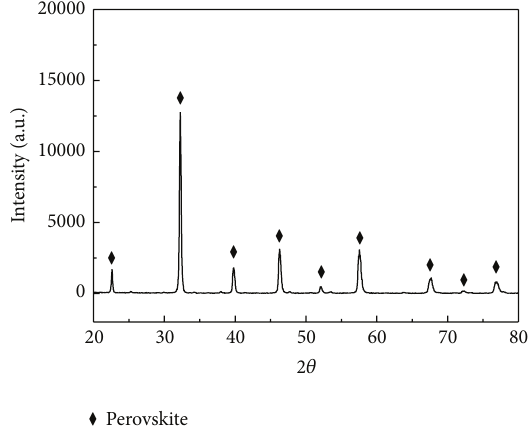
Figure 3: XRD pattern of the LSTF powder sample heat-treated at 1000 ∘